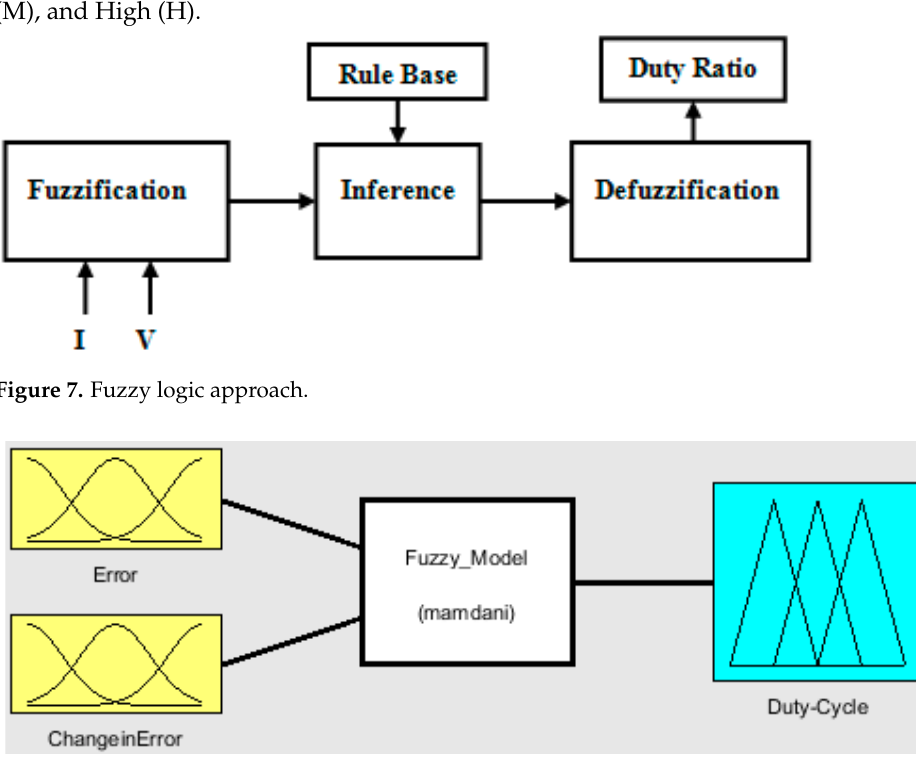
Figure 8. FL designer.